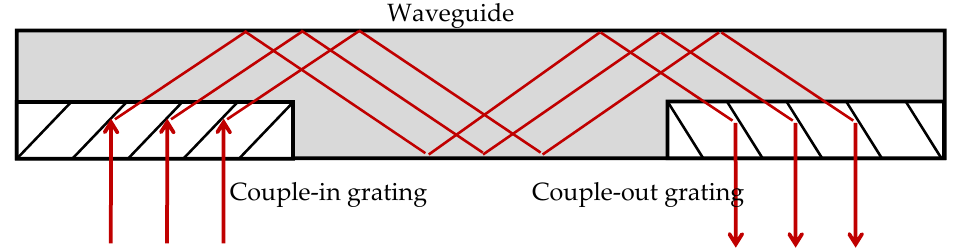
Figure 1. Holographic waveguide by two transmission holograms.